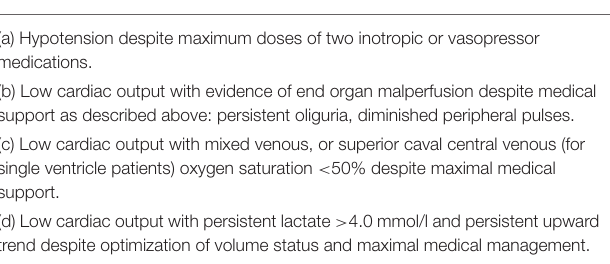
TABLE 4 | Indications to cardiac ECMO according to the ELSO guidelines